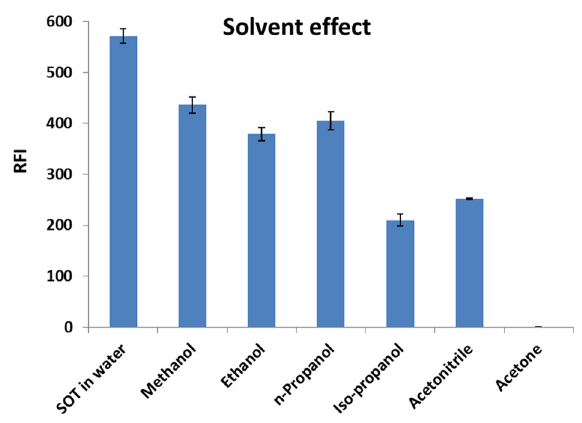
Figure 4: Effect of diluting solvents on the RFI of SOT (180.0 ng/mL) and n=5.